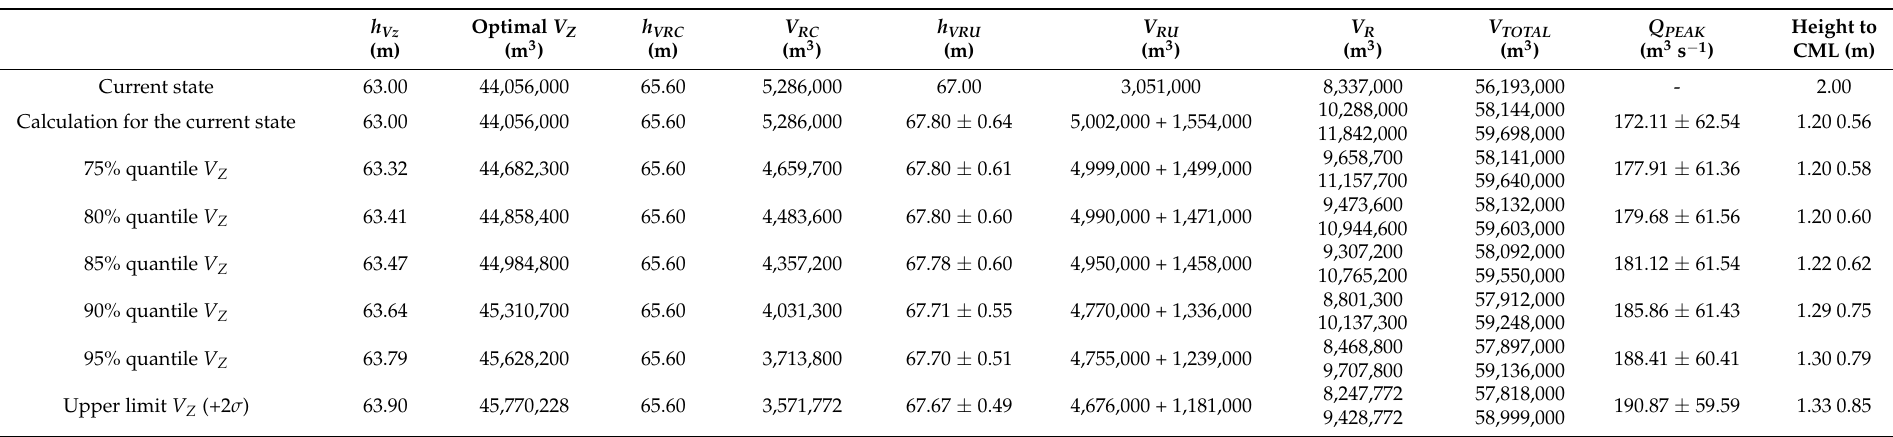
Table 5. The calculated volumes of water in the reservoir and the corresponding heights of water in the reservoir for selected optimal V Z values (m 3 ), including the peak size of the transformed flood discharges Q 1000